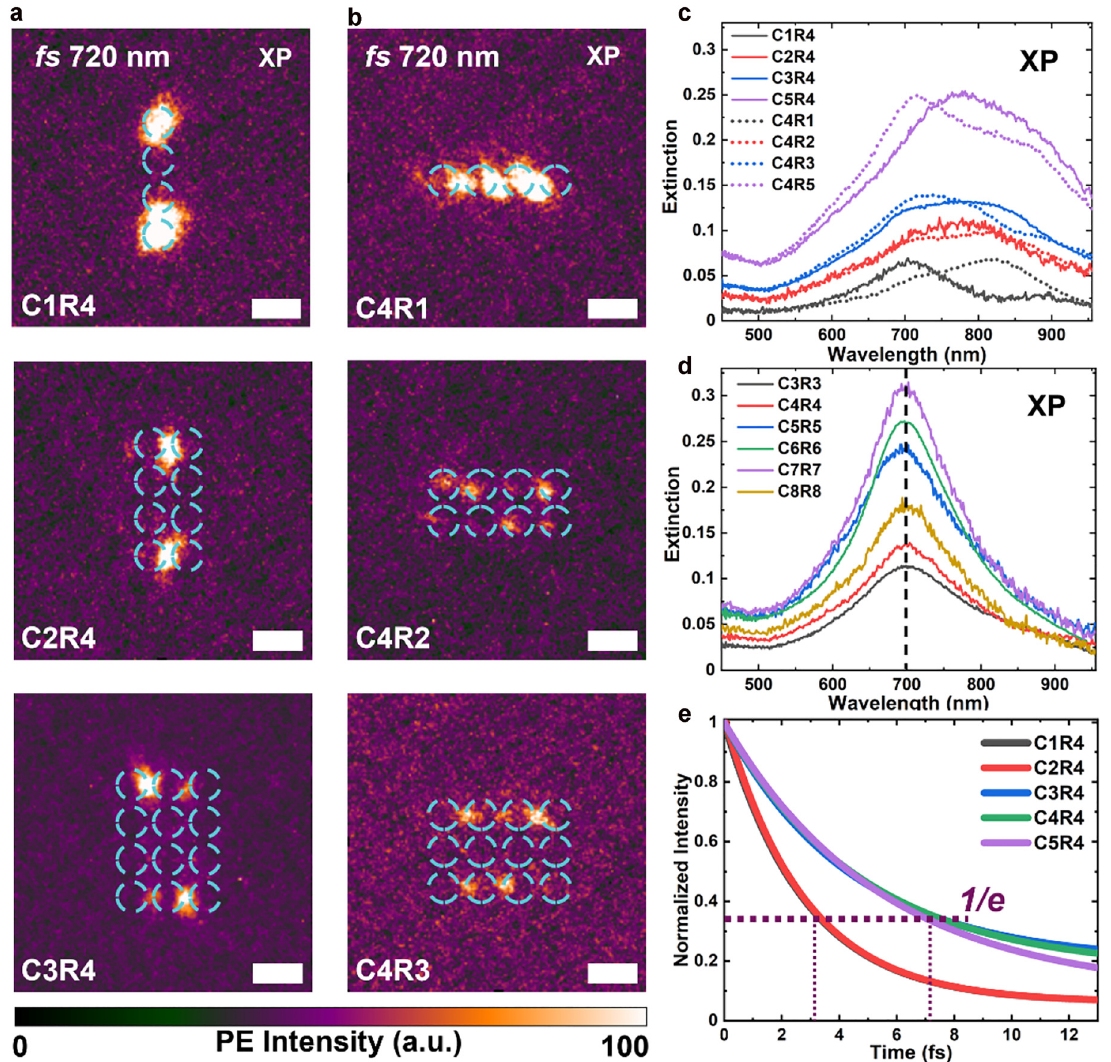
Figure 4: Near-field images and far-field spectra of plasmonic meta-arrays with different numbers of column and row. (a, b) Columns-dependence and rows-dependence of the near-field mode distribution of meta-arrays under XP excitation. The scale bar represented by a short white line in each figure represents 200 nm. The dashed cyan circles represent the spatial location of meta-arrays. The excitation wavelength is 720 nm at their peak wavelength. (c) Columns-dependence and rows-dependence of extinction in square lattices under XP excitation with wavelength range from 450 nm to 955 nm, marked by solid color lines and dashed color lines respectively. (d) Size-dependence of extinction in square lattices under XP light with wavelength range from 450 nm to 955 nm. The dashed black line indicates the single peak wavelength around 700 nm. (e) Simulated fitting curves of the dephasing time of each edge state in square-lattice meta-arrays with increasing column number from C1 to C5 while keeping the row number at 4. The dashed claret lines indicate the values of dephasing